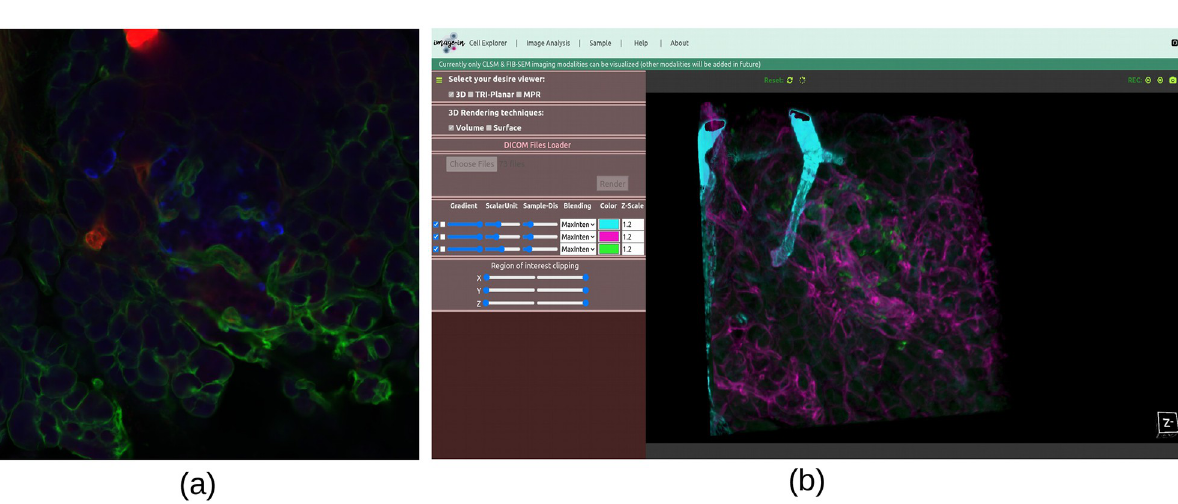
PLOS ONE | https://doi.org/10.1371/journal.pone.0279825 December30,